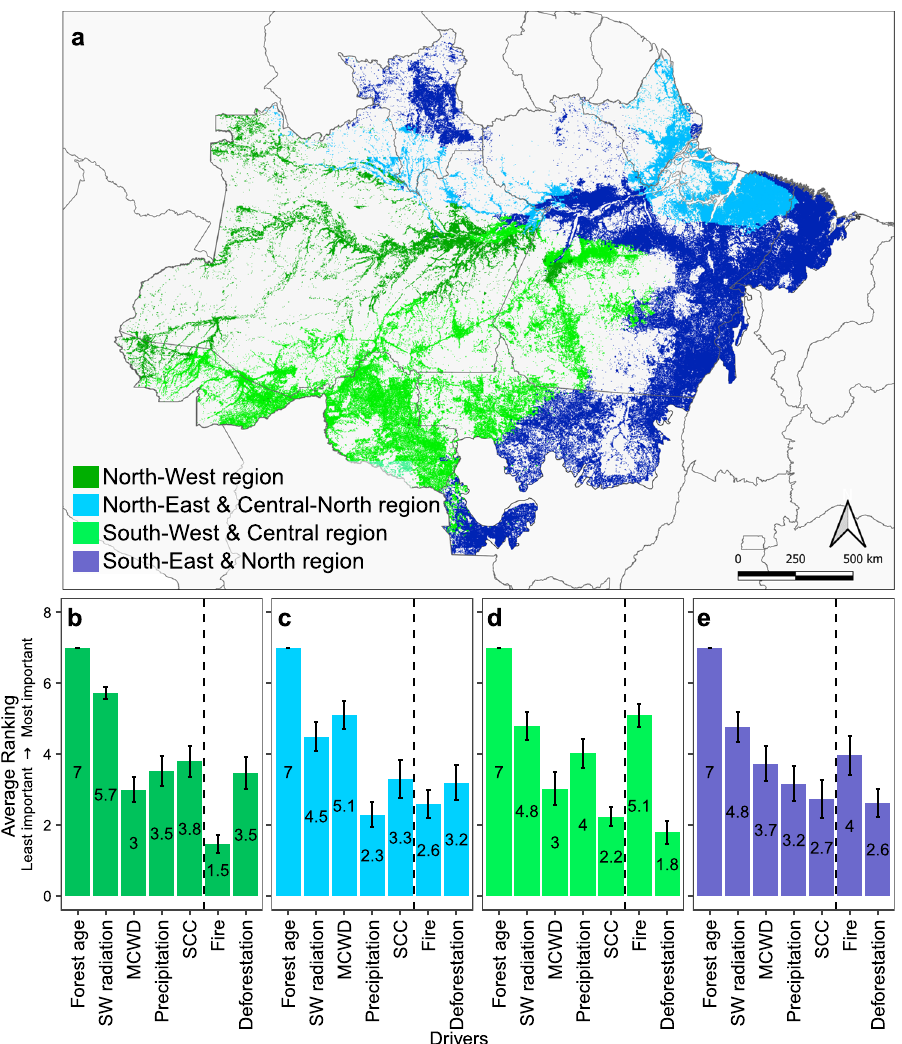
Fig. 2 Importance ranking of environmental and disturbance drivers on secondary forest regrowth grouped by climatological regions. a Regions are grouped according to similarities in Maximum Cumulative Water De fi cit (MCWD), annual average downward shortwave (SW) radiation and annual average precipitation. See Supplementary Table 9 for quantitative interpretations of the regions. The average importance ranking for each of the six variables, as well as Forest age, is shown for b the North-West region, c the North-East and Central-North region, d the South-West and Central region, and e the South-East and North region. The average ranking was calculated following 30 iterations of a conditional random-forest model. The importance has been ranked from least important (1) to most important (7) and the vertical dotted line separates environmental drivers (left) from anthropogenic disturbance drivers (right). The error bars in b – e denote the 95% con fi dence interval. The abbreviation SCC in b – e refers to Soil Cation